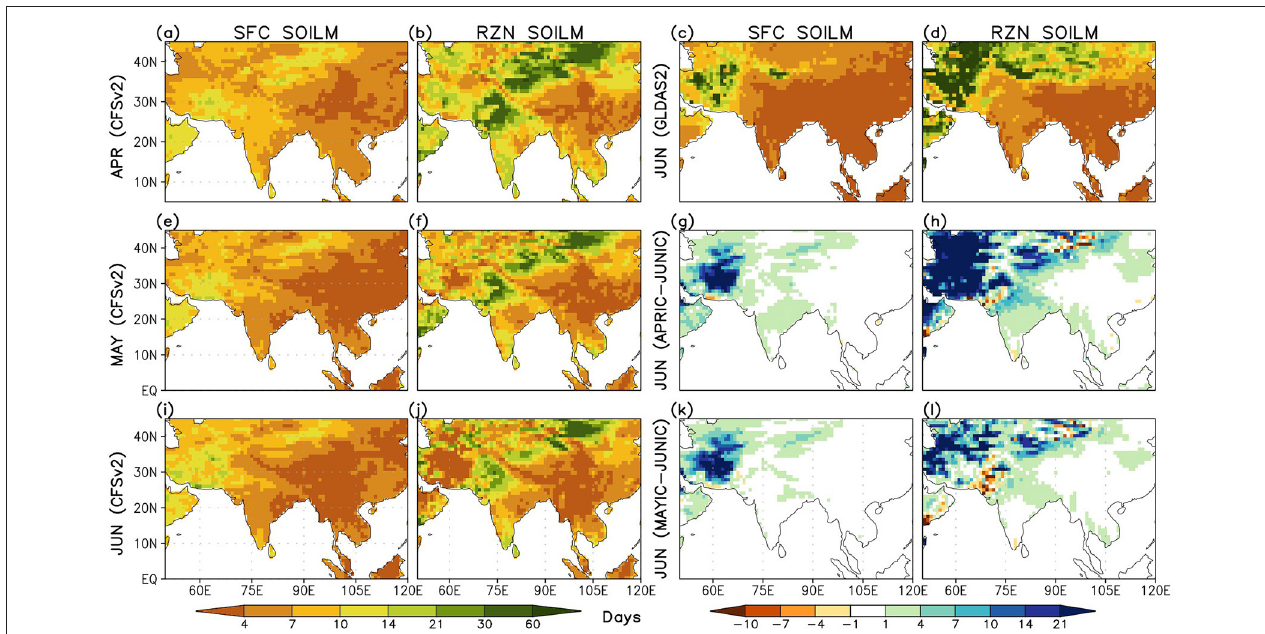
FIGURE 9 | (a) Surface (SFC) and (b) root zone (RZN) soil moisture (SOILM) memory in April based on CFSv2 APRIC hindcasts. (e,f, i,j) show the same for May and June based on MAYIC and JUNIC hindcasts, reespectively. (c,d) shows the soil moisture memory in June based on GLDAS2. Changes in soil moisture memory in June based on (g,h) APRIC-JUNIC, and (k,l) MAYIC-JUNIC hindcasts Units are in